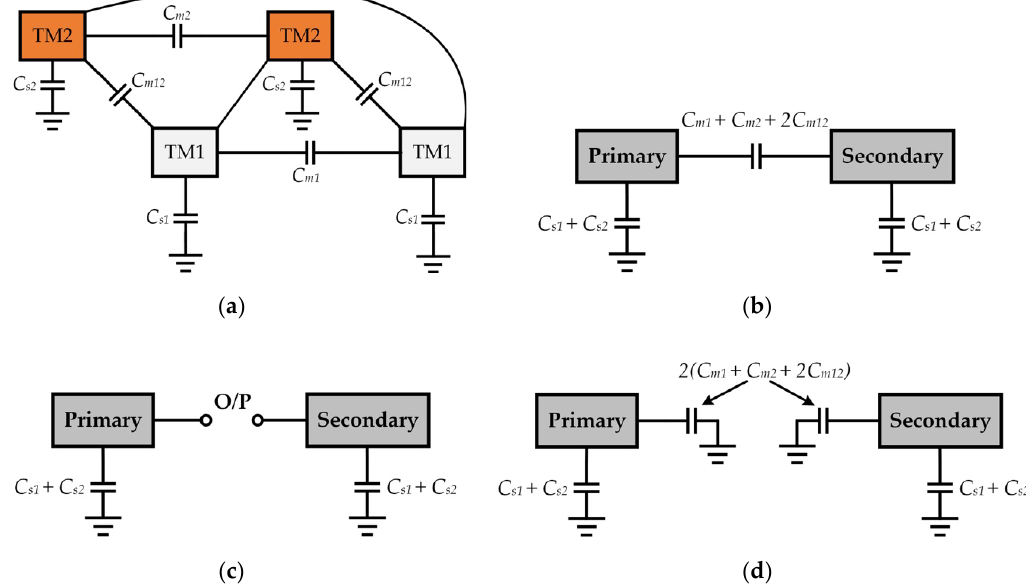
Figure 6. ( a ) Cross-section of the proposed balun; ( b ) simplified model of the proposed balun; ( c ) even mode analysis; ( d ) odd mode analysis.